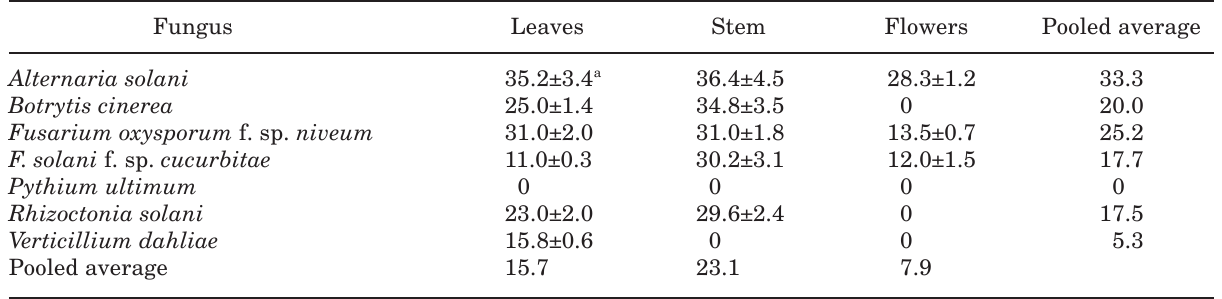
Table 6. Inhibition (%) of fungal growth with different parts of Malvaviscus arboreus . Fungus Leaves Stem Flowers Pooled average Alternaria solani